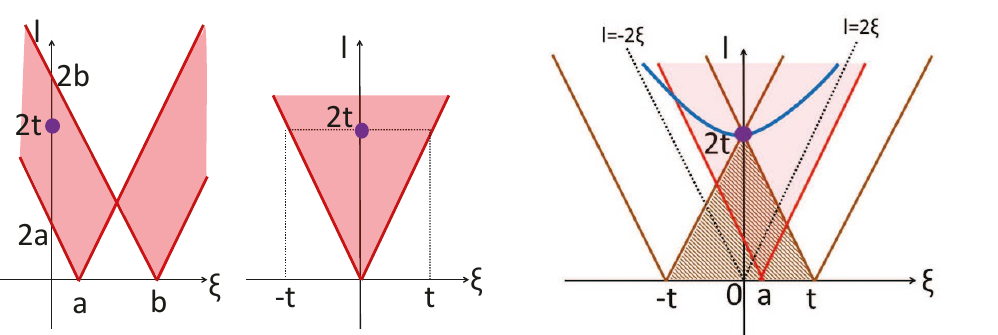
Figure 4 . The integration range R dld(cid:24) of the ED (red regions) and causality range (brown shaded region). The left picture shows the region of integration which computes S A for the subsystems A = [ a; b ]. The middle one shows the same one when A is the half line: a = 0 and b = 1 . The brown shaded region in the right picture describe the range of ( (cid:24); l ) where the local excitation at x = t = 0 can make any physical in(cid:13)uence assuming causality. In all these three pictures, the purple dot at ( (cid:24); l ) = (0 ; 2 t ) represents the peak of ED due to the local quench. In the right picture, p the blue curve near this dot (given by l = 2 (cid:24) 2 + t 2 ) describes the delta functional peaks which are peculiar to holographic local quenches. Note that they are outside of the causality region. The calculations of S A for a (cid:28) t (cid:28) b correspond to integrating the red region in the right picture. We note the left part of the blue curve gradually gets into the red region, which gives the logarithmic growth of EE.